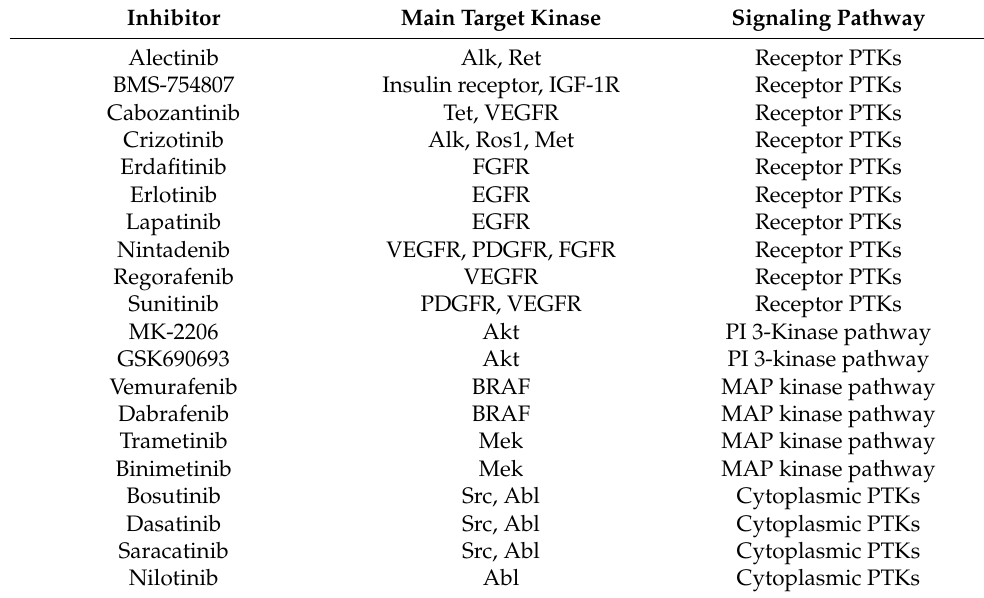
Table 2. Protein kinase inhibitors used to probe the oncogenic signaling mechanism of DU-4475.